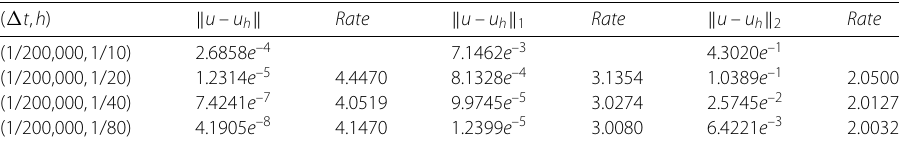
Table 1 The error for different space step h at t = 1